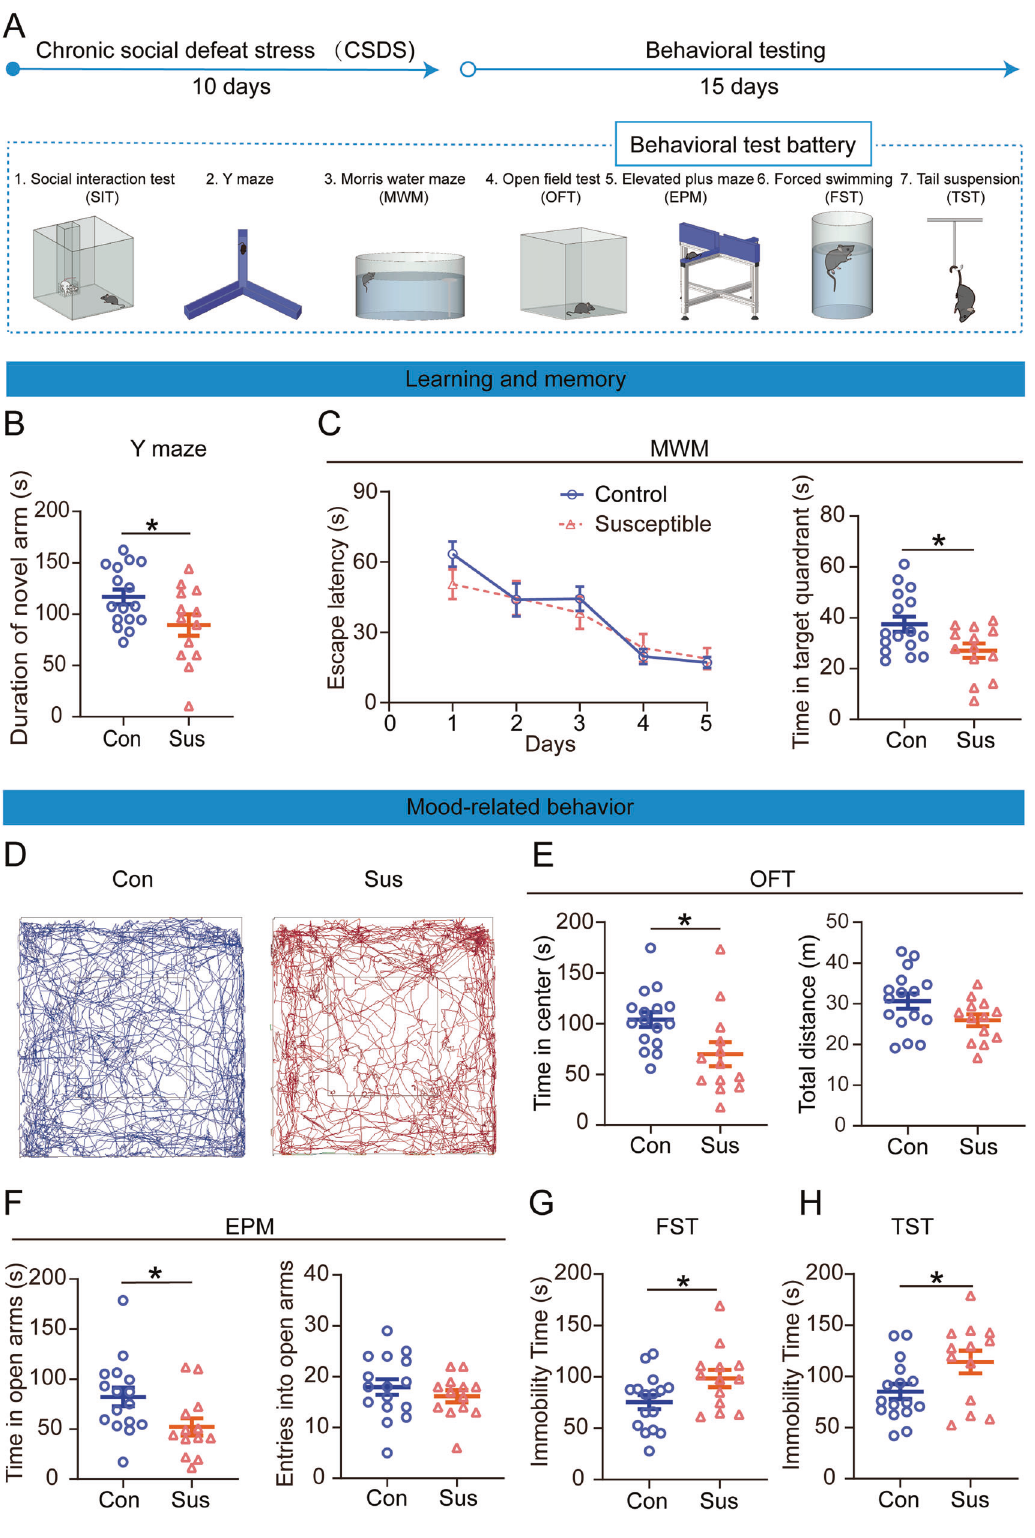
recovered for 30min at 34°C in ACSF, saturated with 95% O 2 and 5% CO 2 . The sections were stored at room temperature until further analysis. The acute slices were transferred to a recording chamber perfused with O 2 - saturated ACSF at a rate of 2ml/min (25°C). Fluorescent neurons of the PC were visualized using an upright microscope (Nikon Eclipse FN1, Nikon,